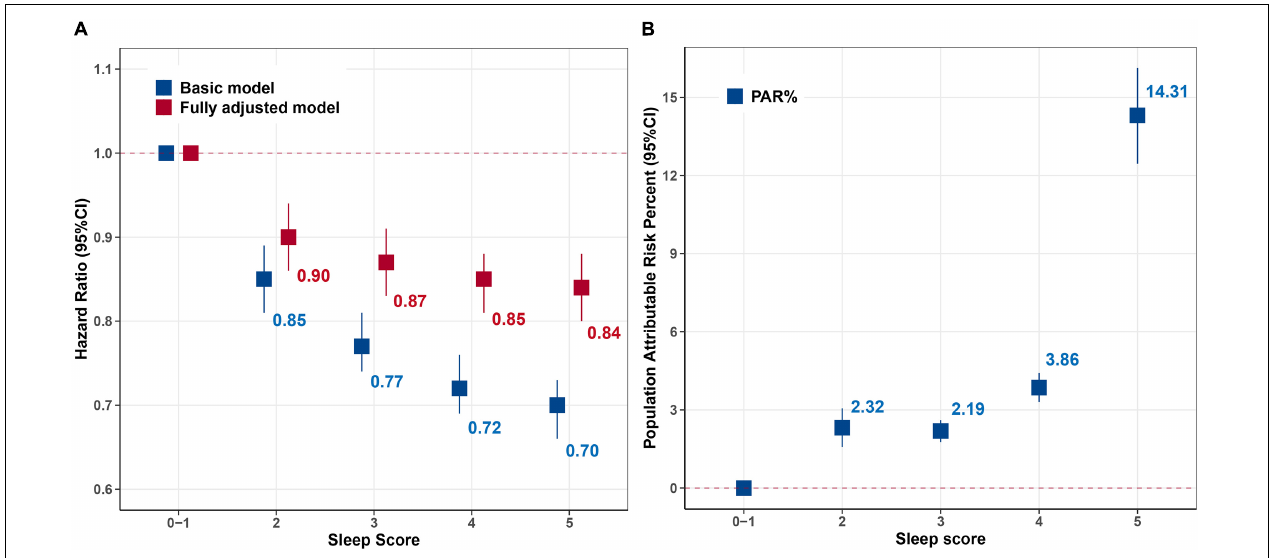
*Basic model: adjusted for age, sex, and ethnicity. † Fully adjusted model: additionally adjusted for Townsend Deprivation Index, education, BMI, smoking status, alcohol consumption, physical activity, healthy diet, family history of diseases (cancer and CCVD), and medication (sleep-related drugs and aspirin/ibuprofen). a Each group was compared to participants with poor sleep quality.